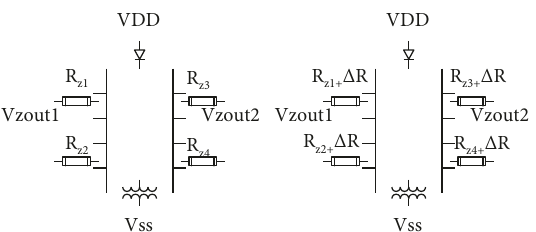
Figure 4: Schematic diagram of the working principle of the acceleration sensor in the z -axis direction: (a) az